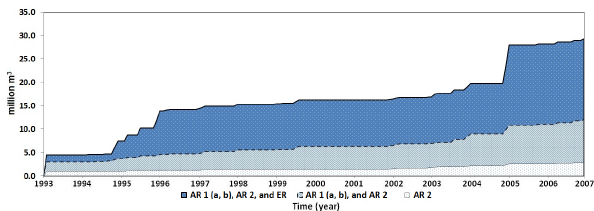
Fig. 12. Cumulative recharged water estimated by groundwater model from the FWS system zone 2 (AR 2), all FWS systems (AR 1 (a, b) and AR 2) and all FWS zones plus ephemeral river channel (AR 1 (a, b), AR 2, and ER) for the entire model period.